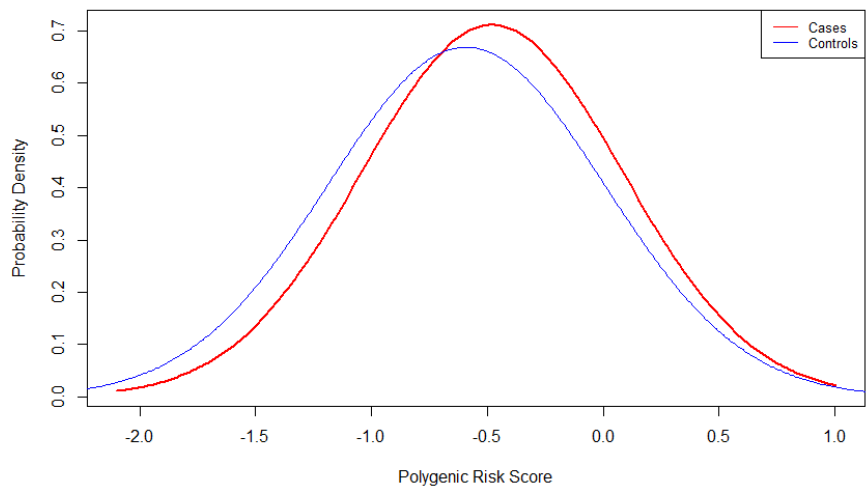
Figure 1. PRS (polygenic risk score) distribution between PD (Parkinson’s disease) cases and controls before imputation. This plot shows the probability density versus PRS in cases and controls.